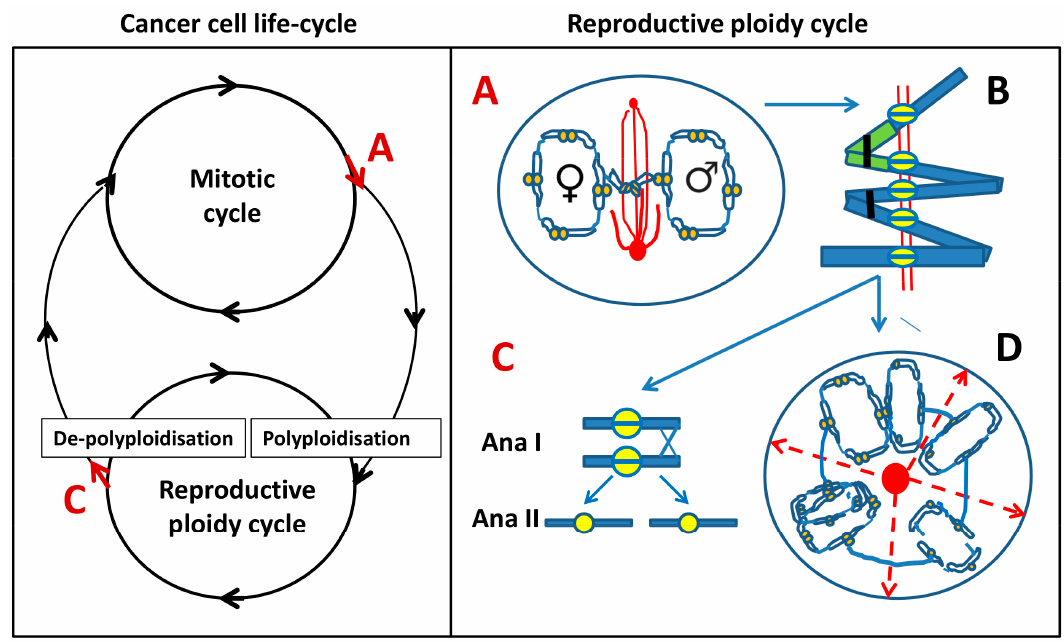
Figure 1. Left : Model of cancer cell life cycle that is composed of two reciprocal cycles: mitotic and reproductive ploidy cycle. Red arrows at A and C denote asymmetric cell fate decisions, indicating potential exit points for each of the two cycles. Right : The components of reproductive ploidy cycle: A —a cell enters pseudo-mitosis (PM) and segregates replicated parental genomes with end-to-end linked chromosomes and mitosis-uncoupled spindle, lying perpendicular to the axis of the two chromosome groups. B —scheme of the end-to-end linked inversely oriented bivalents (depicted as a green–blue-stained pair) and representing a tandem chain of end-to-end linked genome dyads in an endoprophase, a positioning that can allow both zig-zag and co-parallel bi-valent orientation. Homologous bivalents are connected at subtelomeric regions (black clips); recombination is likely occurring between sister centromeres (yellow split rings). AURKB likely provides the microtubule attachment and prevents separation of cohesed centromeres at a monopolar spindle. C —linear de-polyploidisation by bipolar meiosis I-like reductional division (Anaphase I), followed by a second Anaphase II division (omitting S-phase), returning the cell into a mitotic cycle. D —alternative variant of de-polyploidisation, in which a cell has passed from A and B , through karyotomies using semi-spindles, and bipolar and multipolar spindles with dicentric bridges, including possible re-assortings by pedogamic fusions of the neighbouring karyotomy products and subsequent release of cellularised sub-nuclei through radial cleavage furrows (dashed red arrows), originated from a fused centrosome-containing mid-body (red circle). The released cell(s) may again enter the reproductive cycle, or even a mitotic cycle, possibly through an intermediate